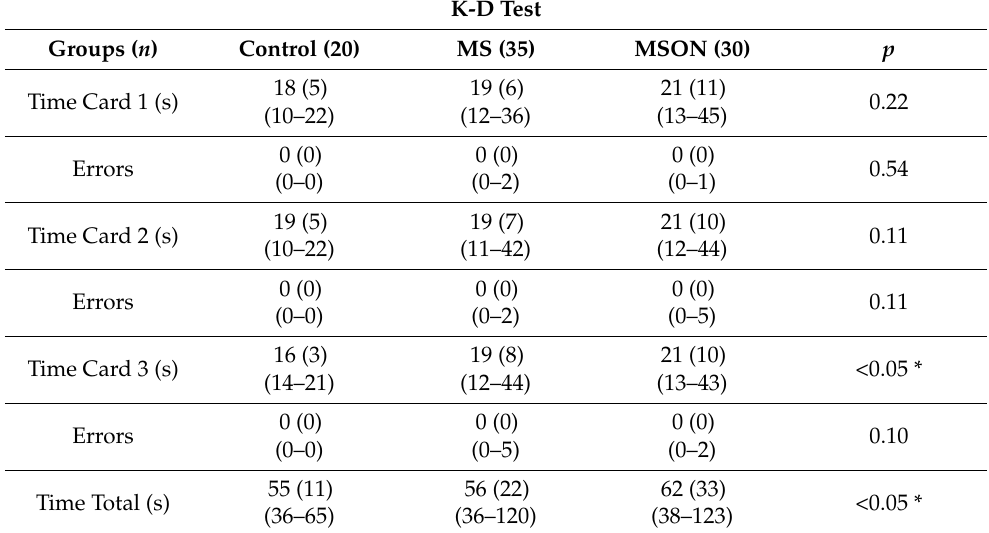
Table 2. Median (and interquartile range) of the three study groups for K-D test. Minimum and maximum values were represented in square brackets. Statistically significant differences were marked with an asterisk